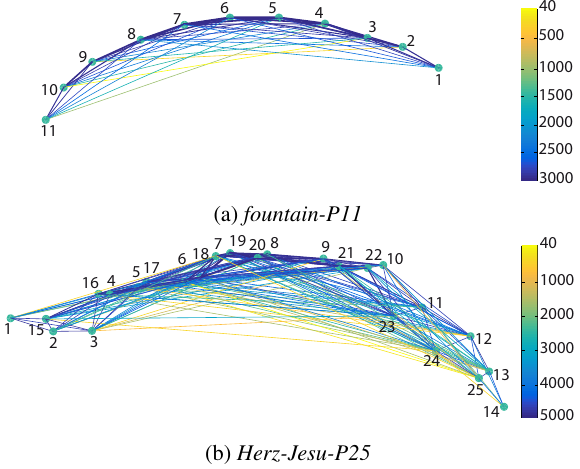
Figure 3: Visualisation of the graph. Colour and thickness of the edges refer to the number of homologous points found between each corresponding